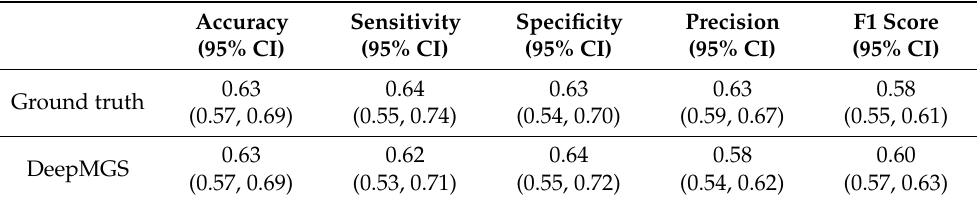
Table 3. Comparison of the performance between the DeepMGS and ground truth in distinguishing pain and no pain conditions.